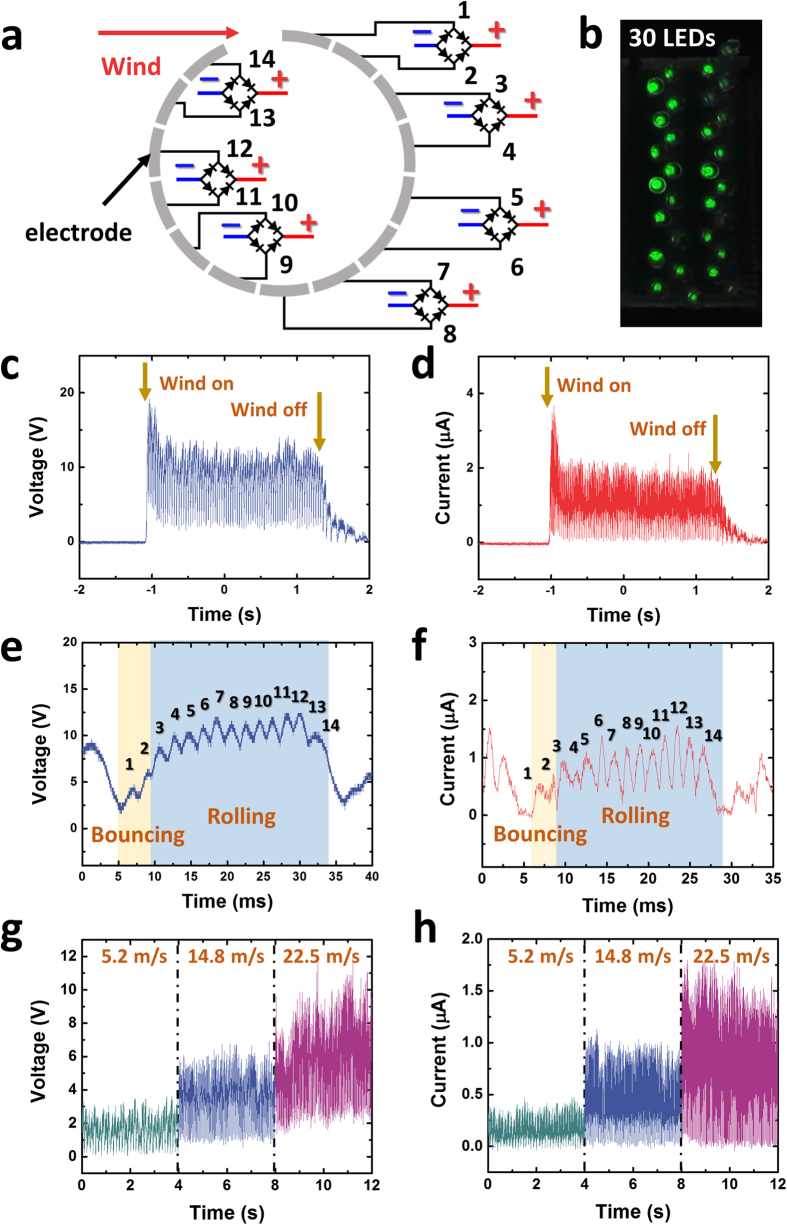
The WR-TENG as a wind energy harvester with multiple units.(a) A patterned electrode connected as a free-standing mode TENG. (b) The WR-TENG lighting 30 LEDs. The (c) VOC, (d) ICC output, and (e) magnified VOC, (f) ICC output of a multiple patterned WR-TENG at wind velocities of 22.5 m/s. The (g) VOC and (h) ICC outputs of a multiple patterned WR-TENG based on wind velocities.